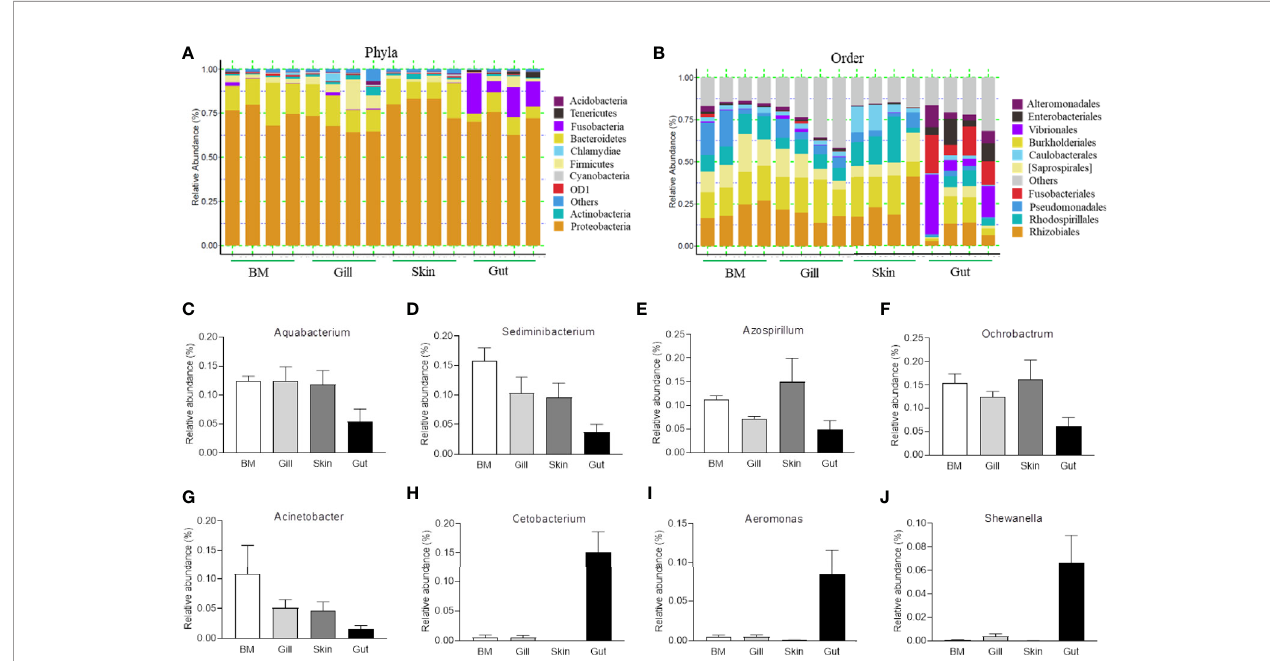
FIGURE 1 | Composition and distribution of the bacterial microbiome in common carp at different mucosal sites. (A) Composition and relative abundance of the dominant bacterial taxa in common carp samples (BM, gills, skin, and gut) at the phylum level. (B) Composition and relative abundance of the dominant bacterial taxa in common carp samples (BM, gills, skin, and gut) at the order level. (C – I) The distribution of several representative dominant bacteria in various mucosal tissues (BM, gills, skin, and gut) in common carp including Aquabacterium (C) , Sedminibacterium (D) , Azospirillum (E) , Ochrobactrum (F) , Acinetobacter (G) , Cetobacterium (H) , Areomonas (I) , and Shewanella (J) , BM, buccal mucosa; Data are representative of 4 individuals (mean ±